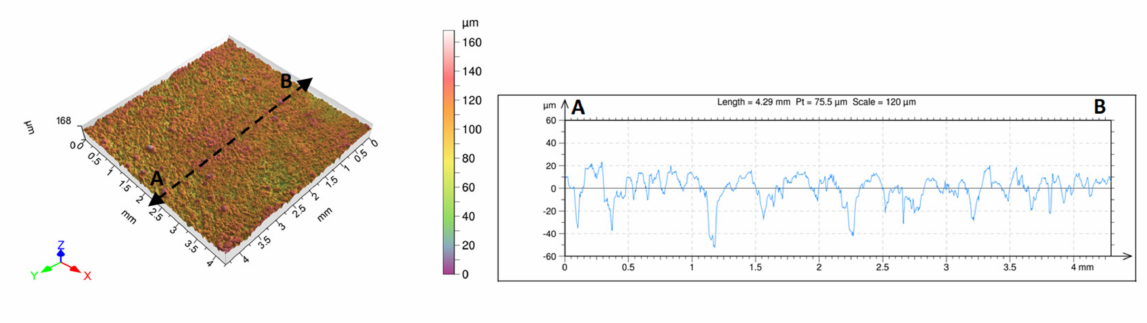
Figure 10. Initial surface topography of Cr-variant-coated rod (A-B is the measurement